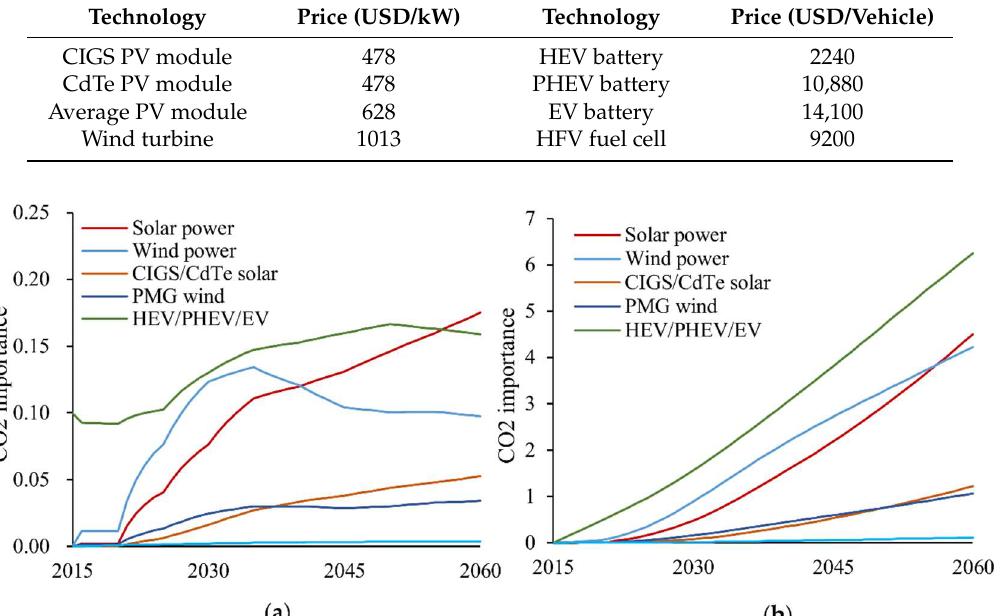
Figure A5. Estimated CO2 importance in each technology in 2DS ( a ) annual ( b ) cumulative.